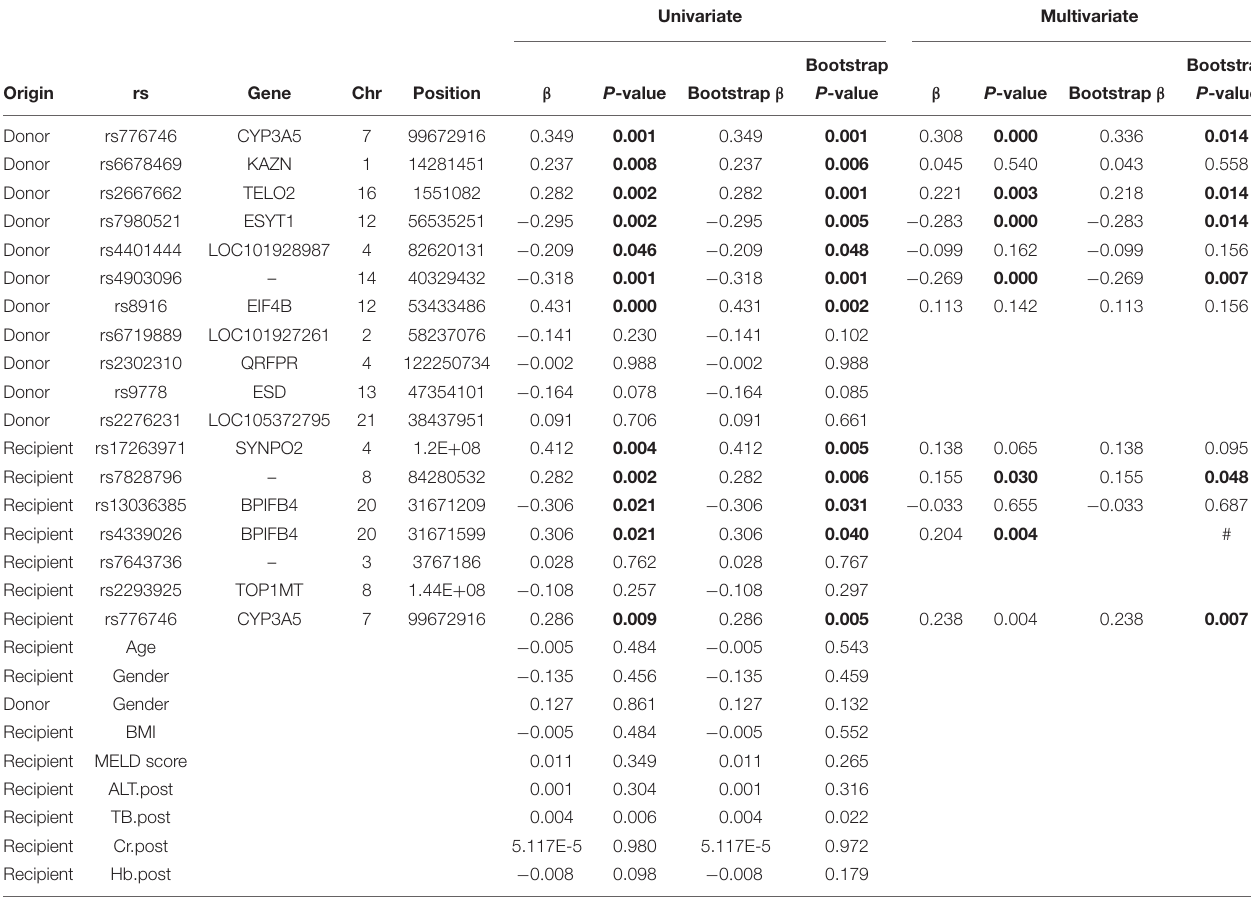
TABLE 3 | Univariate and multivariate regression analysis in stabilizing phase.